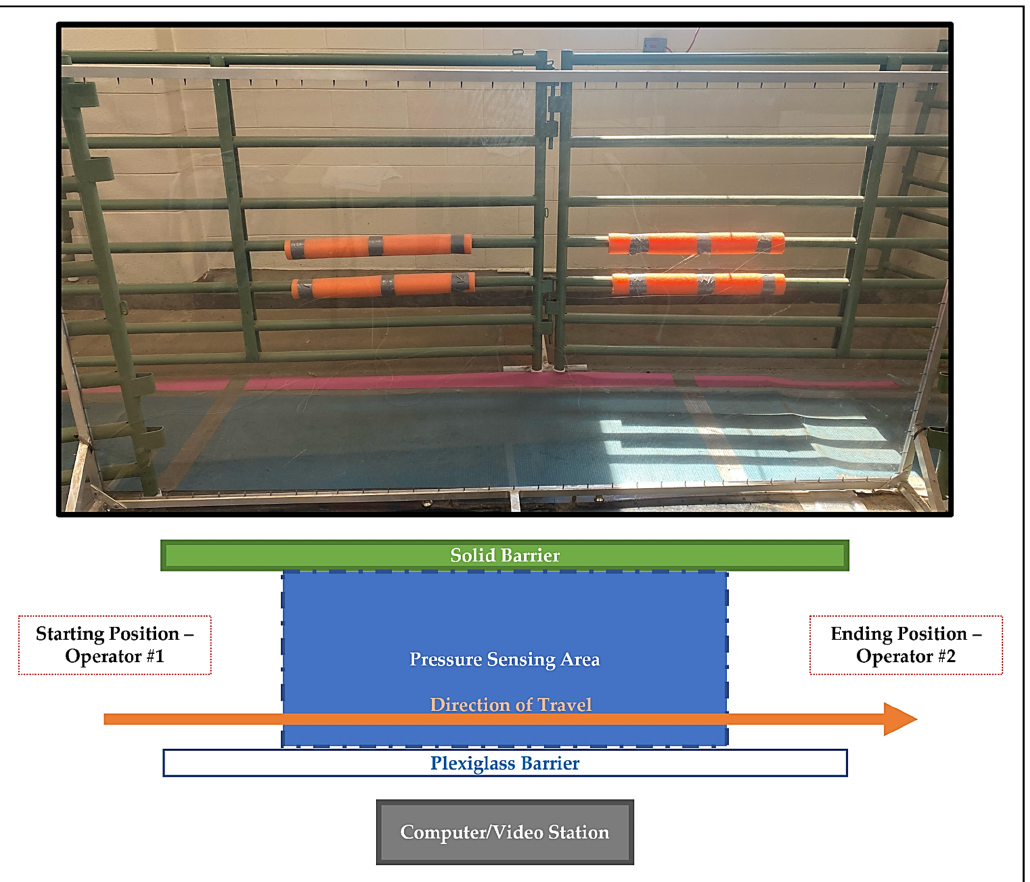
Figure 1. Photograph and associated diagram of data collection area. Goats were allowed to walk at a self-selected pace in the indicated direction of travel from a starting handler to a second handler holding a halter with long lead. The lead was held without tension applied to the halter during the pass to allow for free movement at a normal pace. Enclosure surrounding ending position not pictured above.